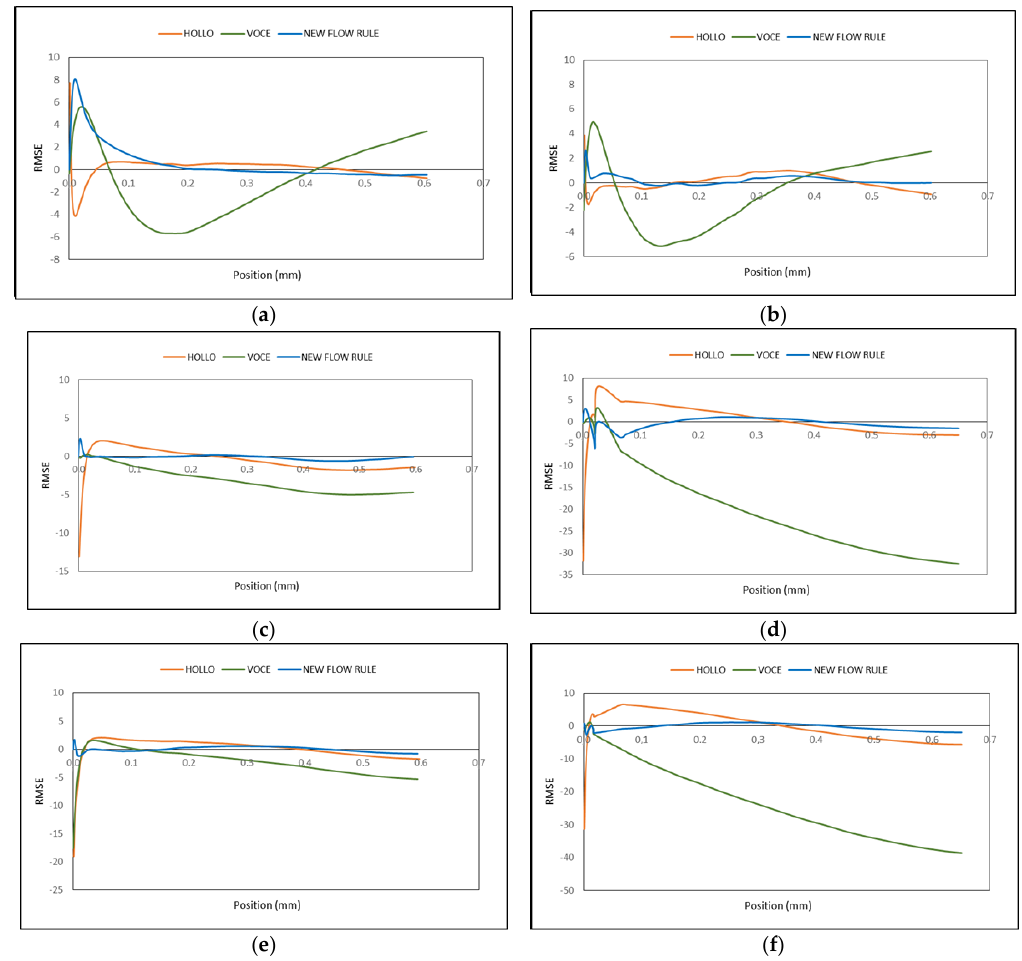
Figure 8. RMSE (Root Mean Square Error) graphs of each flow rule in relation to the experimental curve for AA3103: ( a ) AA3103 at N0 and 25 °C; ( b ) AA3103 at N0 and 250 °C; ( c ) AA3103 at N2 and 25 °C; ( d ) AA3103 at N2 and 250 °C; ( e ) AA3103 at N4 and 25 °C; ( f ) AA3103 at N4 and 250 °C.